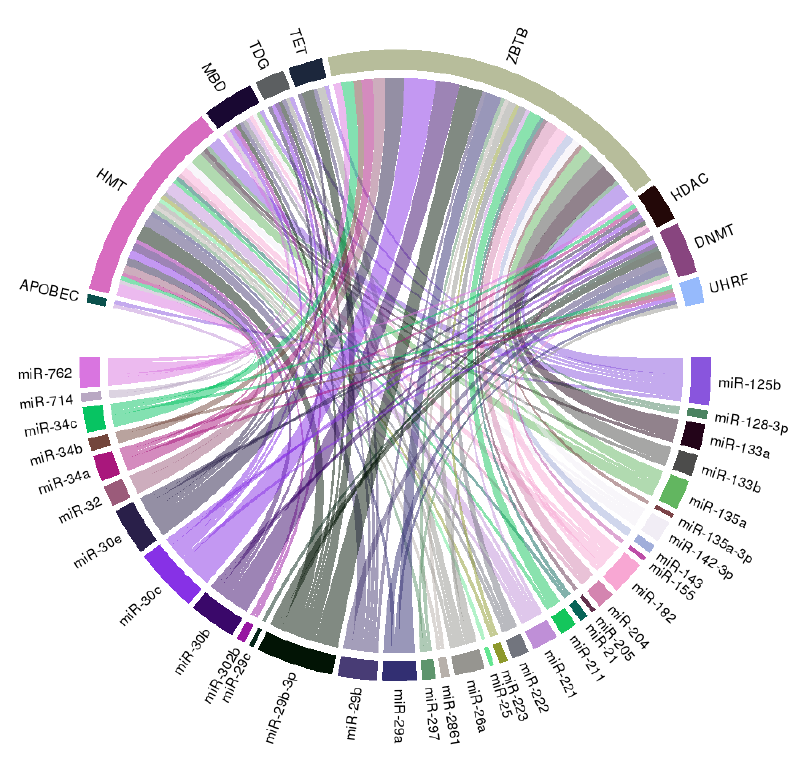
Figure 3. A circular ribbon chart depicting interactions between literature-identified miRNAs in Table 1, and key molecules involved in DNA methylation and histone modification. The thickness of the ribbon is reflective of the scores assigned by the literature addressing the relationship based on miRNAtap (R package version 1.16.0; R foundation for Statistical Computing, Vienna, Austria) and topGO (R package version 2.34.0; R foundation for Statistical Computing, Vienna, Austria).